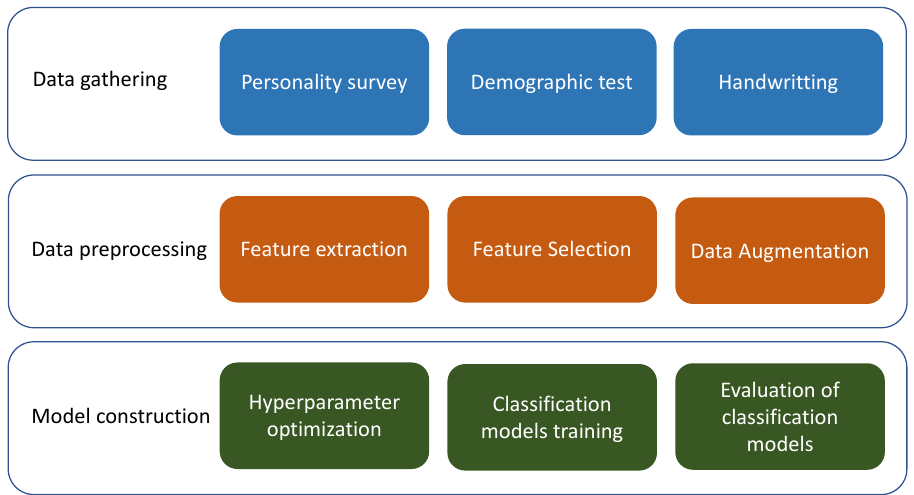
Figure 1. Overview of the construction of the model for personality prediction.